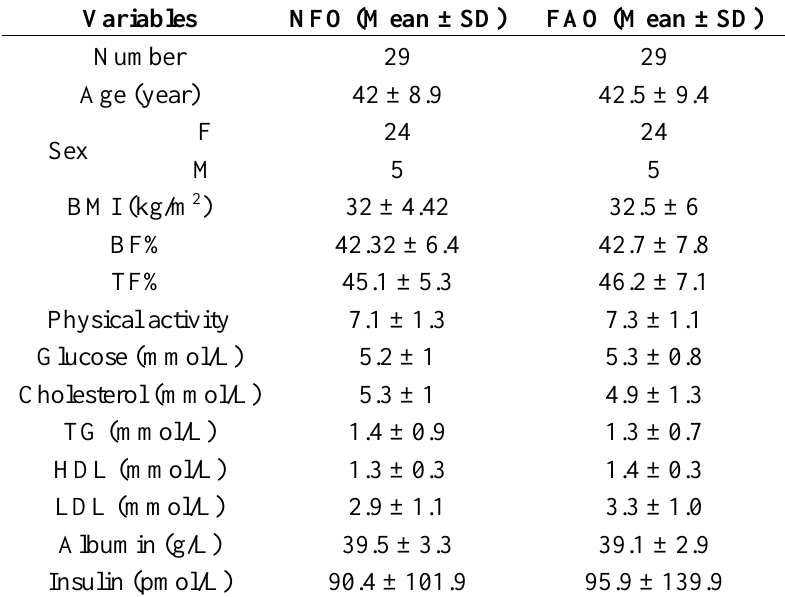
Table 1. Characteristics of the study participants *.